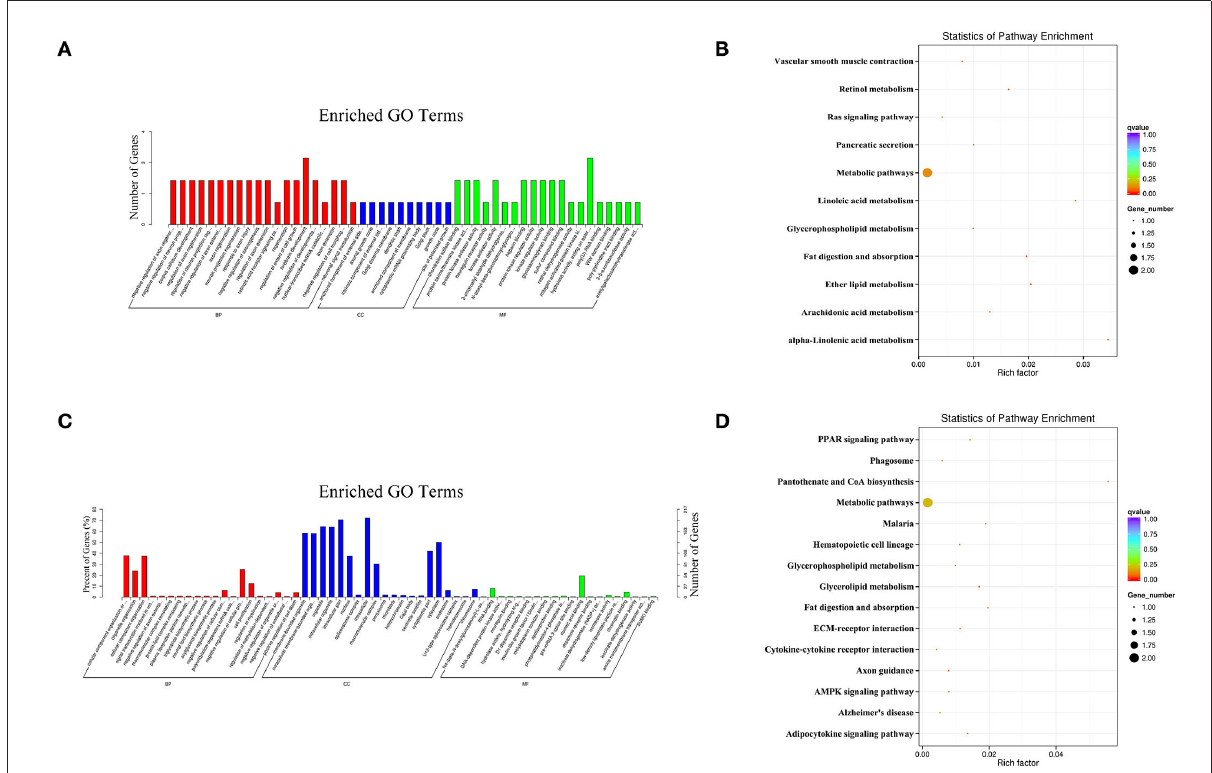
FIGURE6 The most enriched GO terms (A) and KEGG pathways (B) of the target genes of the DE miRNAs identified in PL vs. PP comparison. The most enriched GO terms (C) and KEGG pathways (D) of the parental genes of the DE circRNAs identified in the PL vs. PP comparison.